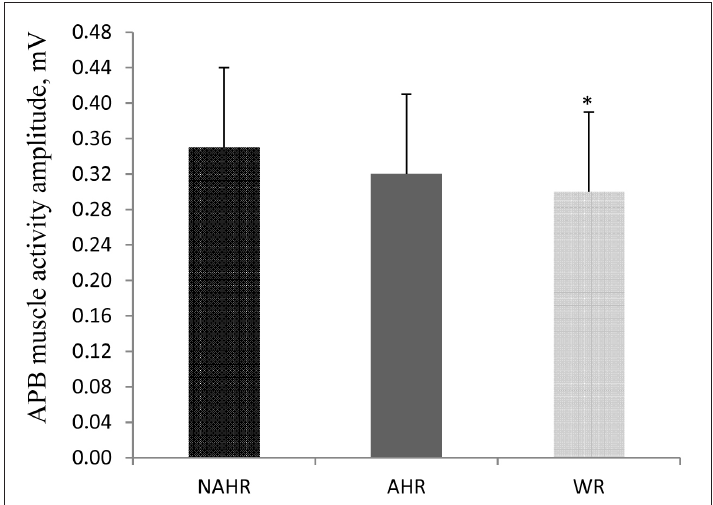
Note. * – statistically significant difference (p < 0.05) between NAHR and WR